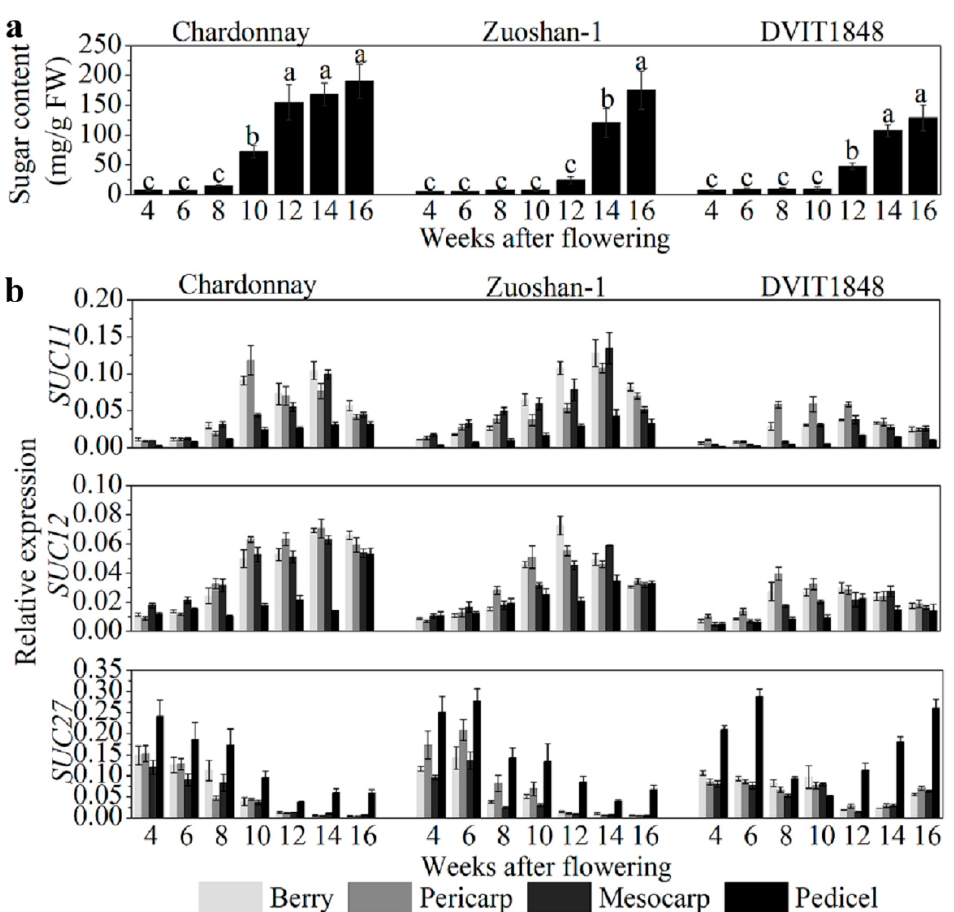
Figure 1. Sugar content and SUT gene expression level analysis in berries from different grapevines. ( a ) Sugar content analysis of Chardonnay, Zuoshan-1, and DVIT1848 grape varieties. Different letters indicate significant differences ( p < 0.05) among different developing periods within one grapevine, and were determined by one-way analysis of variance (ANOVA) and Tukey’s test. ( b ) Relative expression of SUC11 , SUC12 , and SUC27 in the berry, pericarp, mesocarp, and pedicel of Chardonnay, Zuoshan-1, and DVIT1848 grape varieties, respectively. Gene transcript levels were normalized against reference genes ( EF-1 α and Actin ). The error bar indicated mean ± SD ( n = 3).